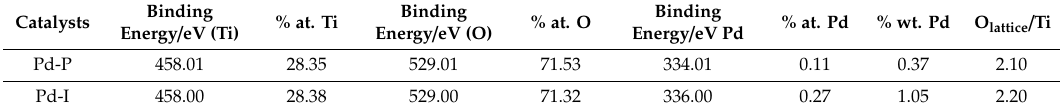
Catalysts. Table 2. XPS results of the Ti, O and Pd regions for the di ff erent modified photocatalysts.